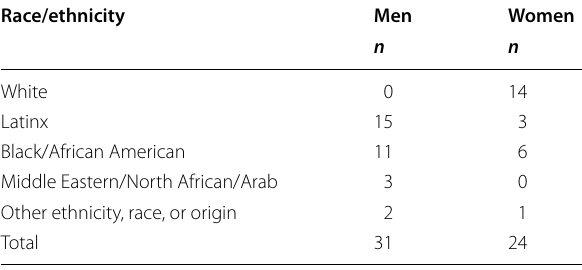
Table 2 Gender of interviewees by